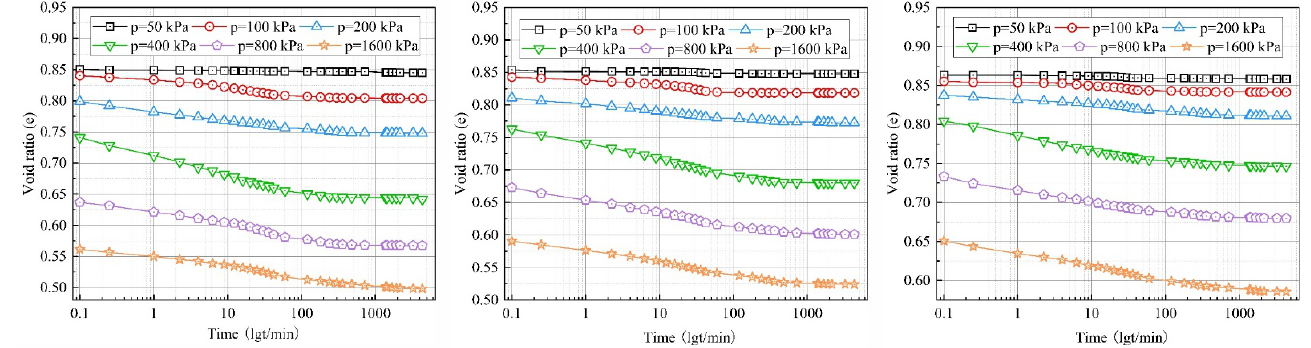
Figure 5. e-lgt curves of different loess